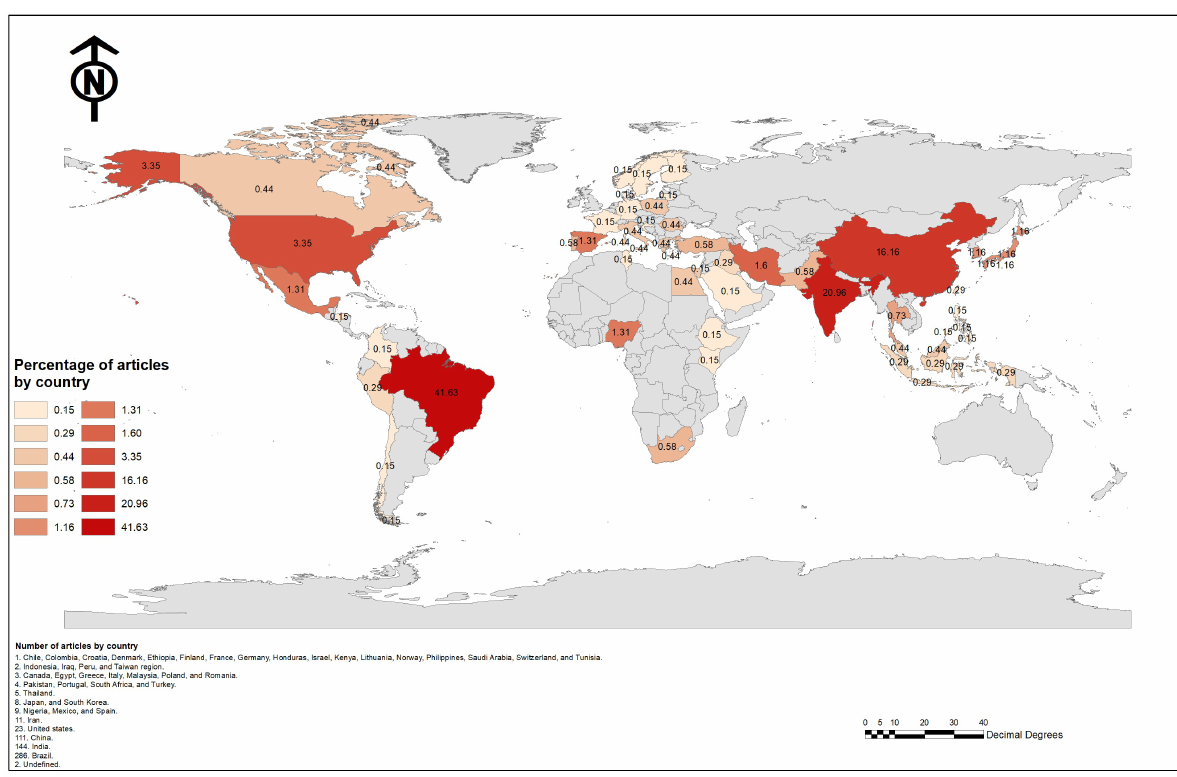
Figure 2. Global distribution of the main countries in which researchers have used the Dickson Quality Index in studies on plant quality. The darker the colour, the higher the percentage of studies in which this index has been used. Prepared in Arcgis ® with data from Scopus,